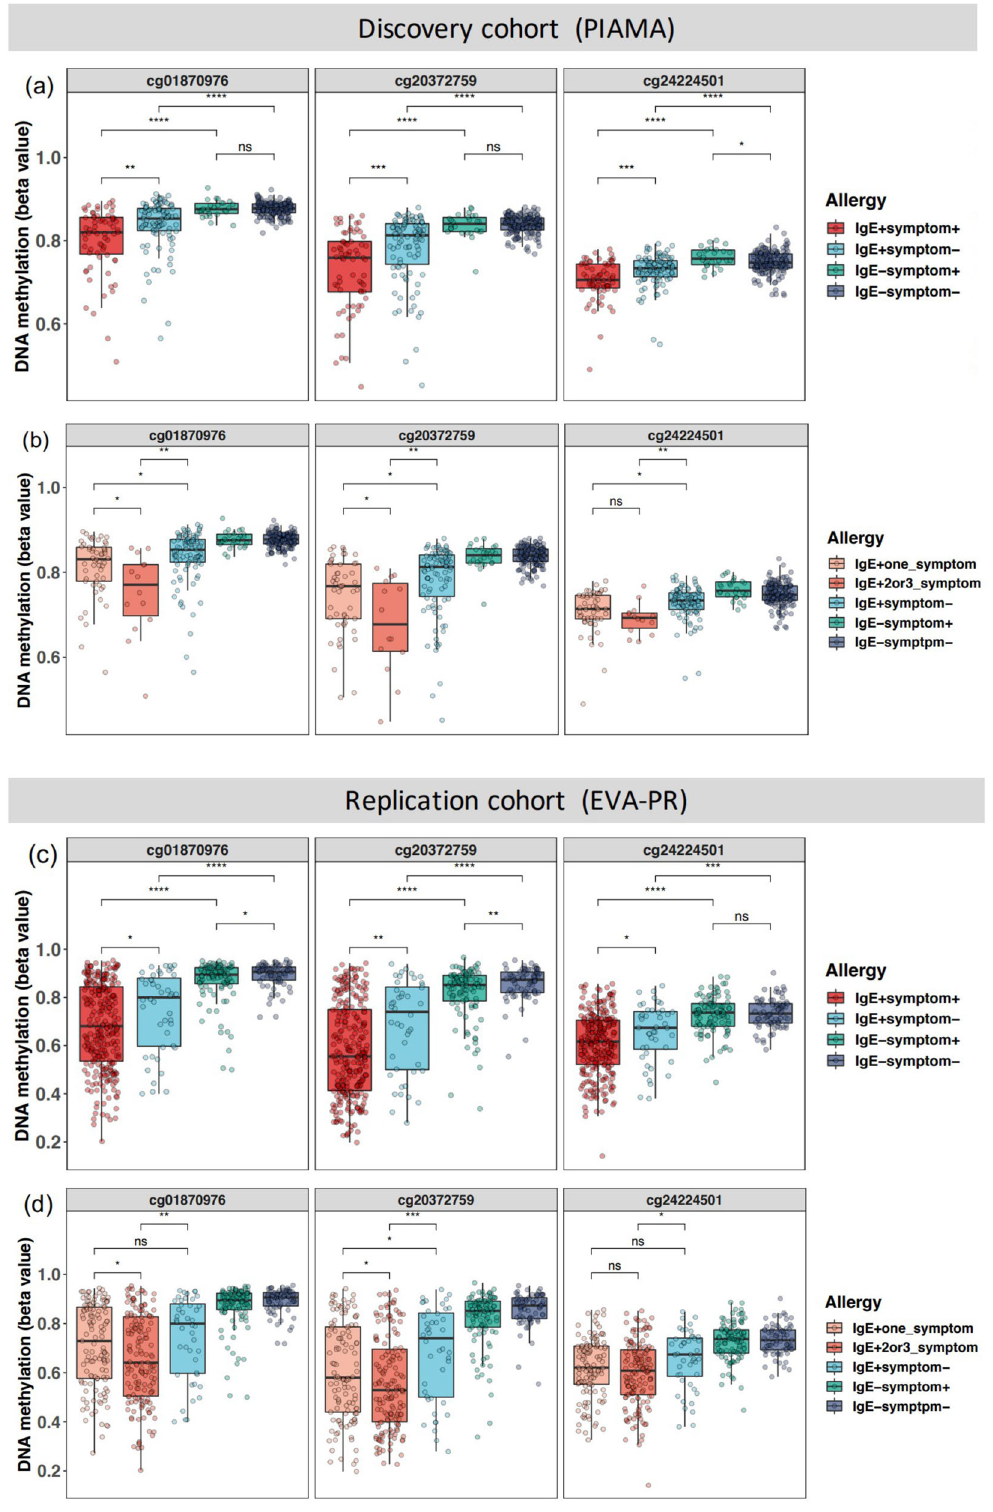
Fig. 4 | DNA methylation levels of three CpG sites in subgroups of allergy phenotype. Methylation levels are shown for the discovery ( a , b , PIAMA, n = 348) andareplicationcohort( c , d , EVA-PR, n =481).Samples werestrati fi ed byboth IgE sensitizationandsymptom( a , c ),and wereadditionallystrati fi edbythenumberof symptoms ( b , d ). The Student ’ s t-test (two-sided) was used to compare the dif- ferencebetweendifferentgroups(* P <0.05;** P <0.01,*** P <0.001, **** P <0.0001, ns not signi fi cant). Box plots show medians and the fi rst and third quartiles